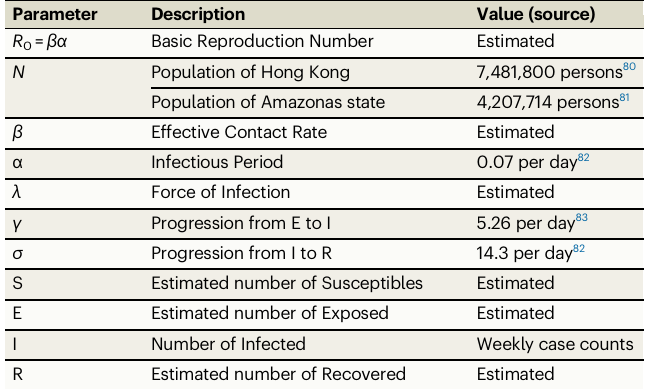
Table 2 | Parameter estimates used within the deterministic SEIR